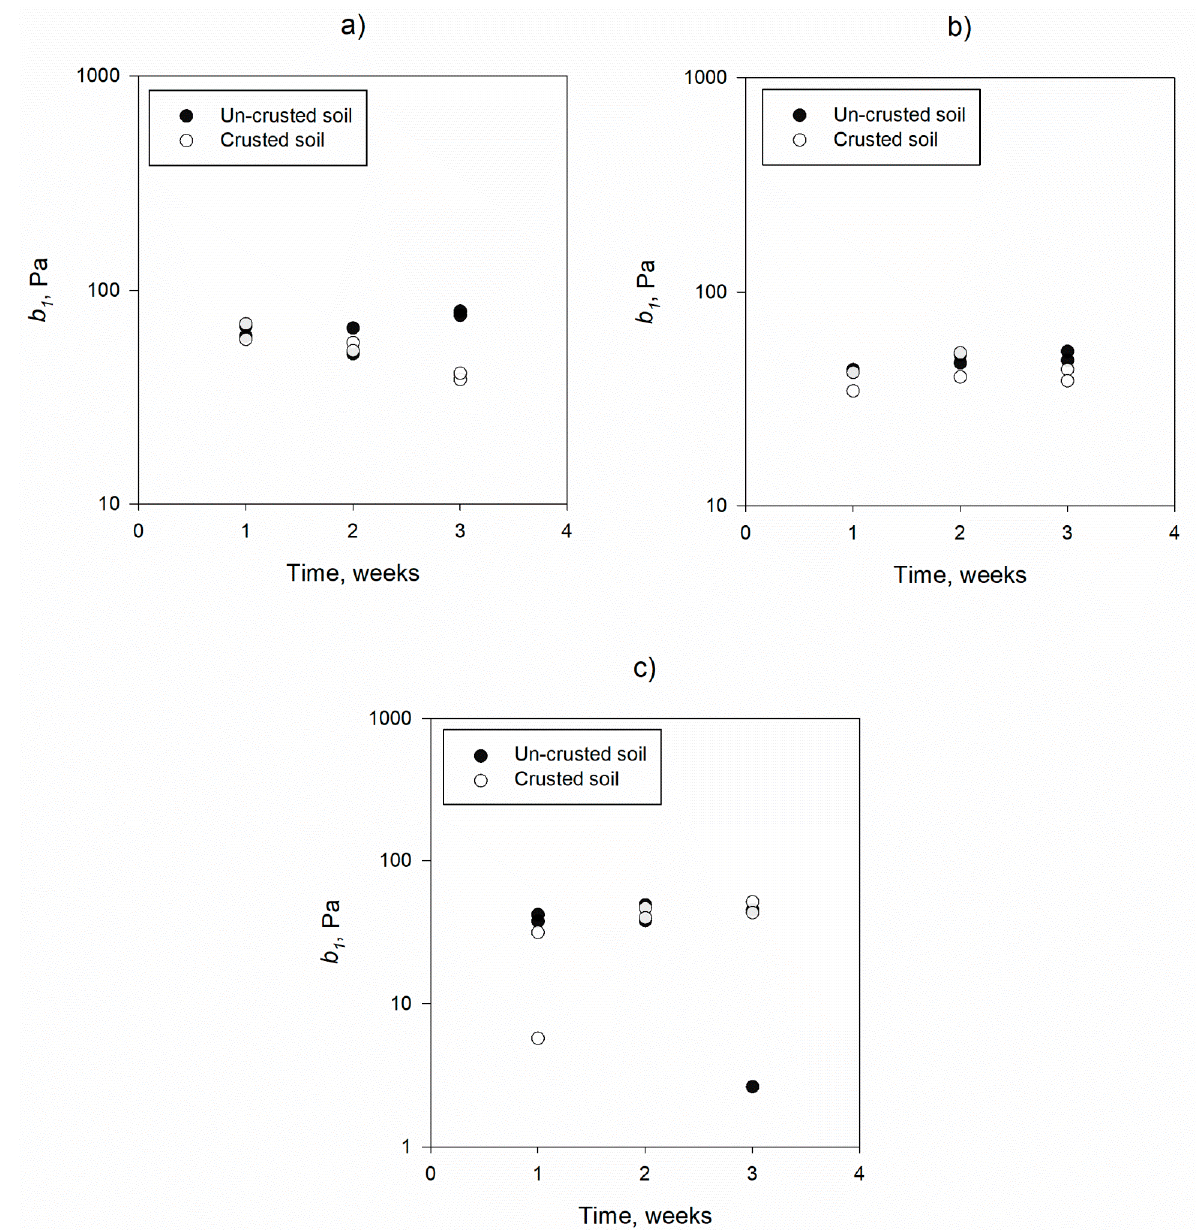
Figure 4. The influence of three different curing times of 1 week, 2 weeks, and 3 weeks on the dimensional soil threshold parameter ( b 1 ) of the Wilson model derived from the JET instrument achieved on soil specimens of crusted and uncrusted soils in the presence of different humic acid concentrations: ( a ) 0% (no humic acid), ( b ) 4%, and ( c ) 8%. Note that each test was